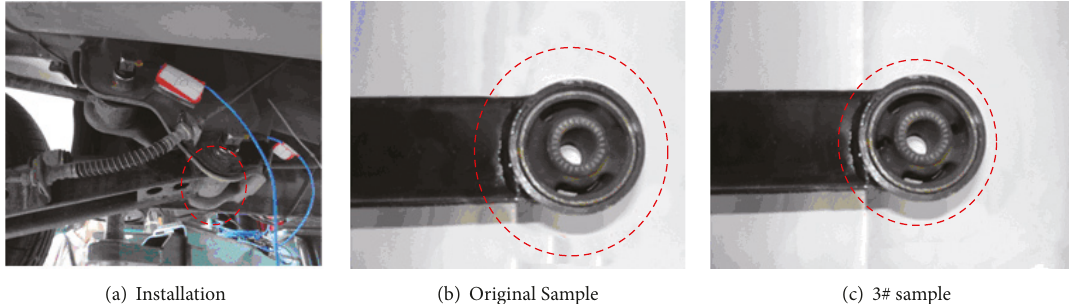
Figure 21: Samples of rear suspension lower arm